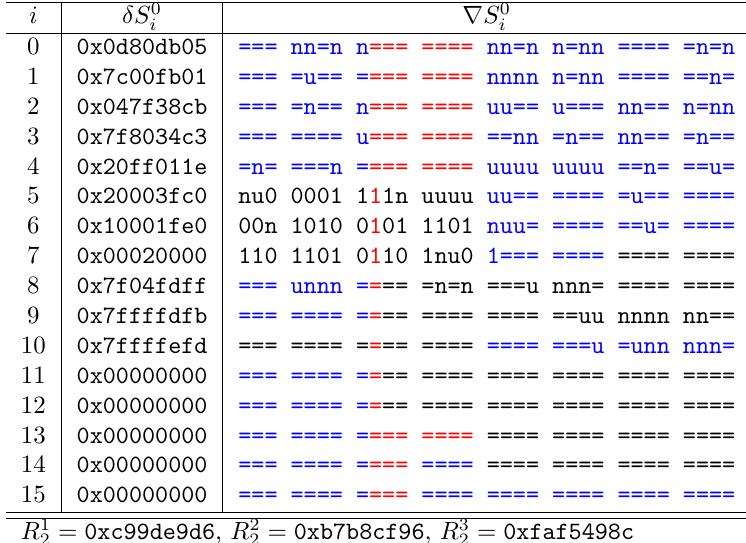
Table 2: The input difference for the attack on 31-round ZUC-256 , where the positions to set constants in the loading scheme are marked in red and the positions to set key bits are marked in blue (69 weak key